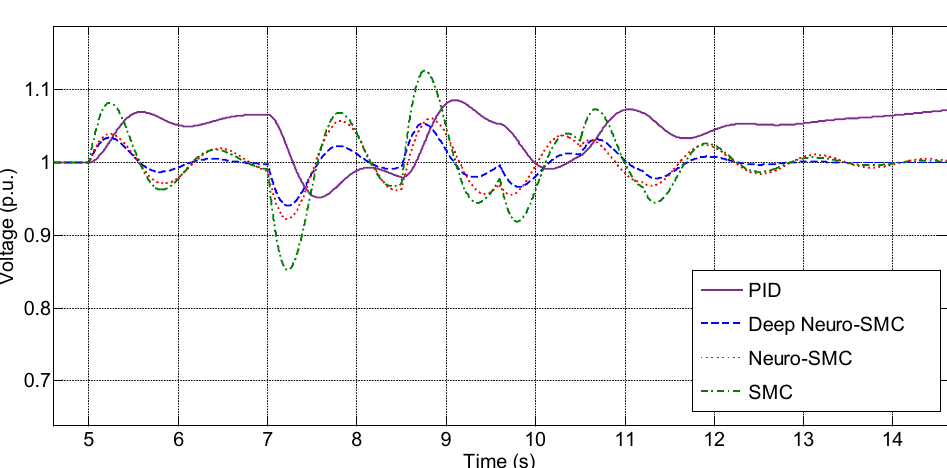
Figure 11. Bus number 5 voltage diagram (third case).